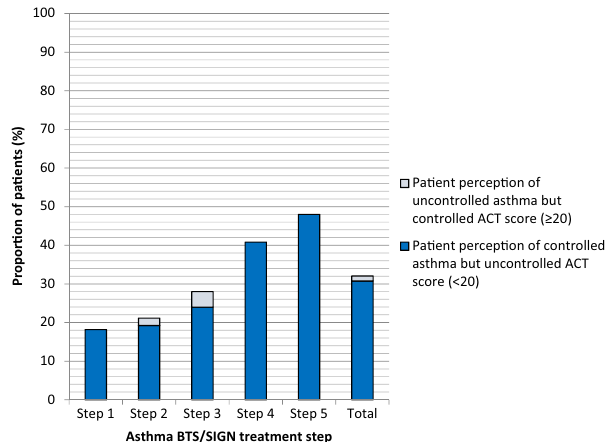
Fig. 4 Patient perception of asthma control compared to their ACT